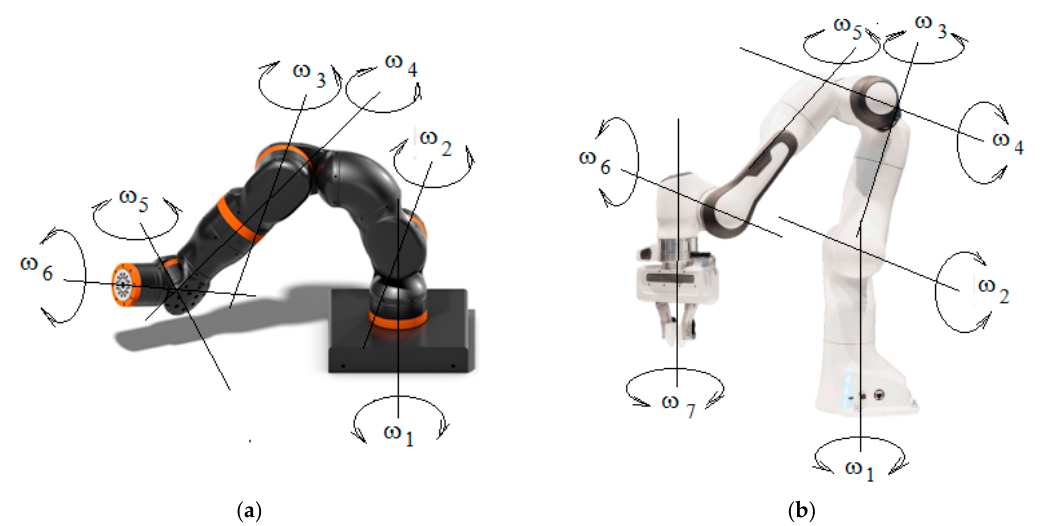
Figure 5. Collaborative robots: ( a ) Rabel robotic arm; ( b ) Panda robotic arm.